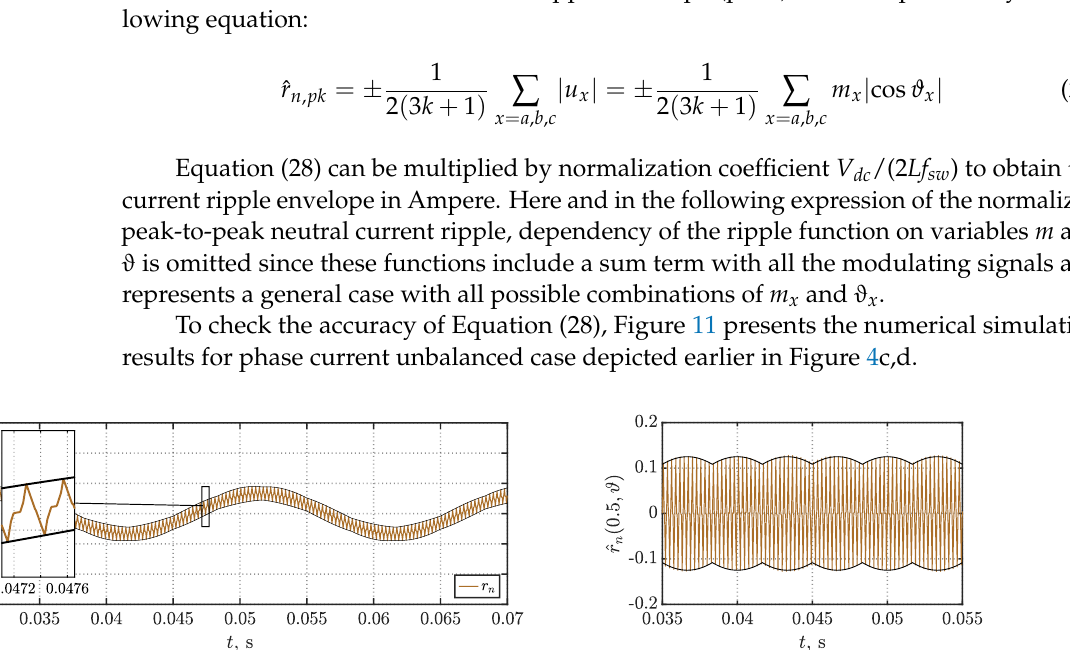
Figure 11. Profile and primary (black) envelope m = 0.5 and k = 1: ( a ) normalized neutral current; ( b ) normalized neutral current ripple.